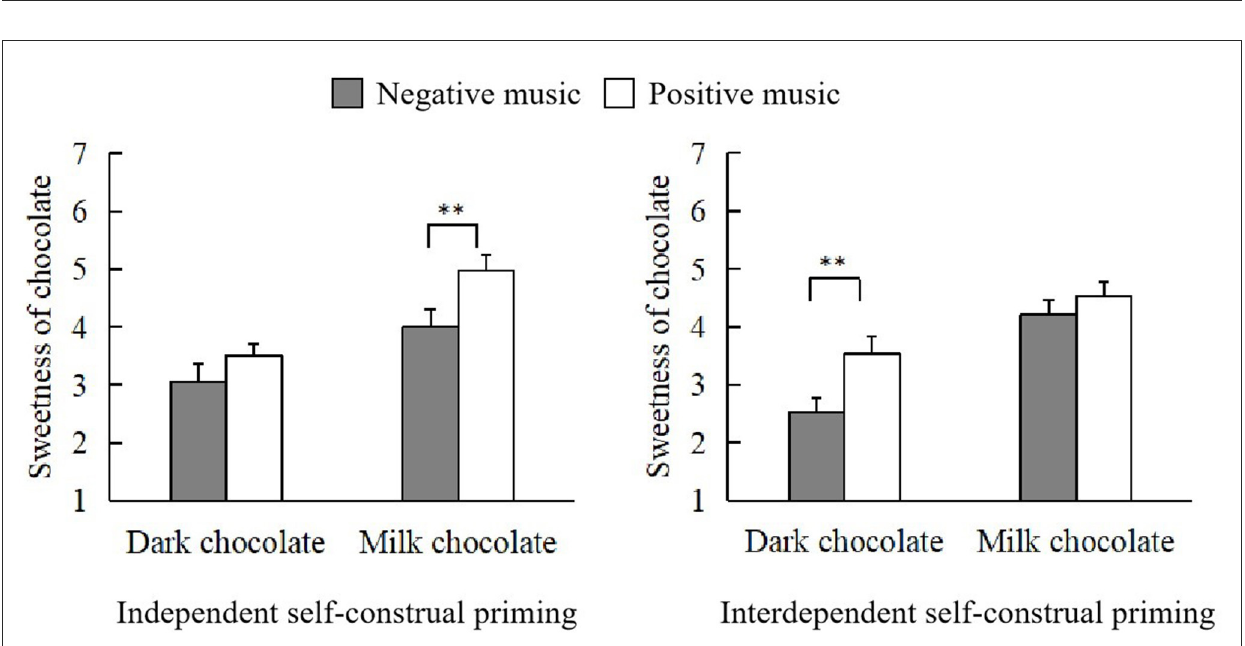
FIGURE3 Triple interaction effect among emotional music, self-construal priming, and chocolate on the sweetness of chocolate. Note that error bars show the standard errors of the means, ** p < 0.01.